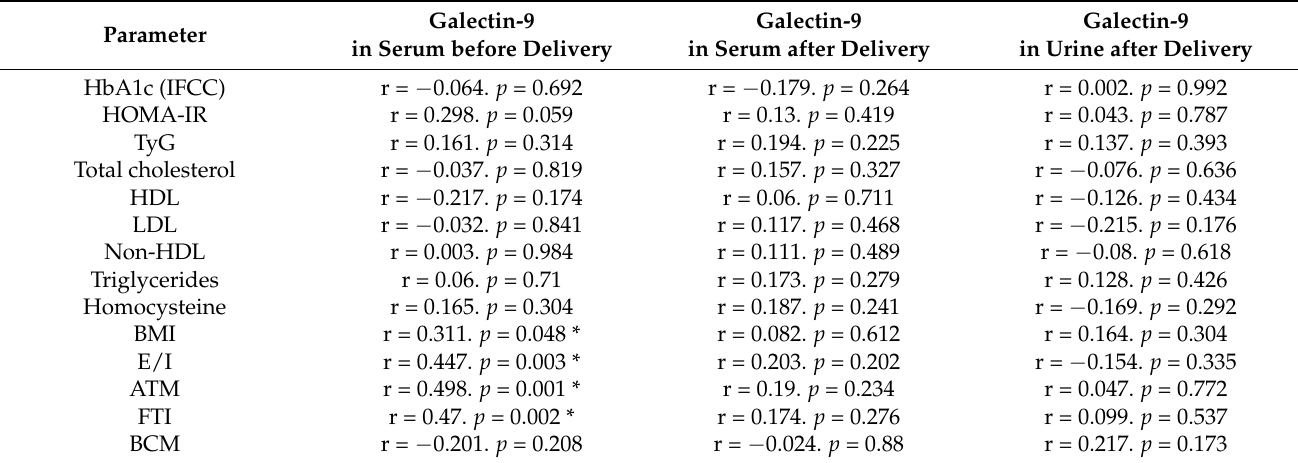
Table 4. Correlations with galectin-9 concentrations.